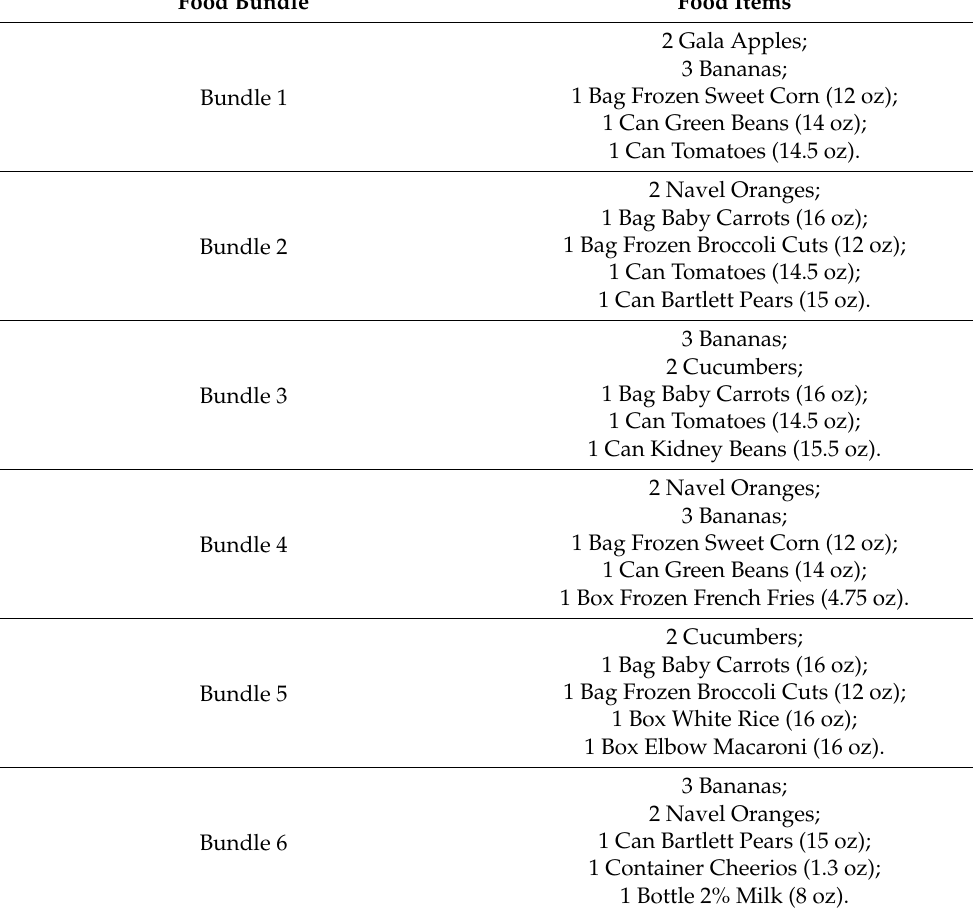
Table 1. Preassembled food bundles featured in the grocery shopping